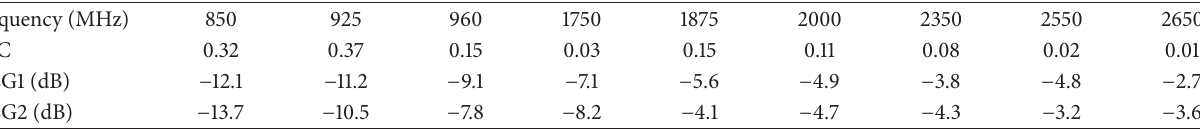
Table 1: Diversity performances of the proposed antenna array.